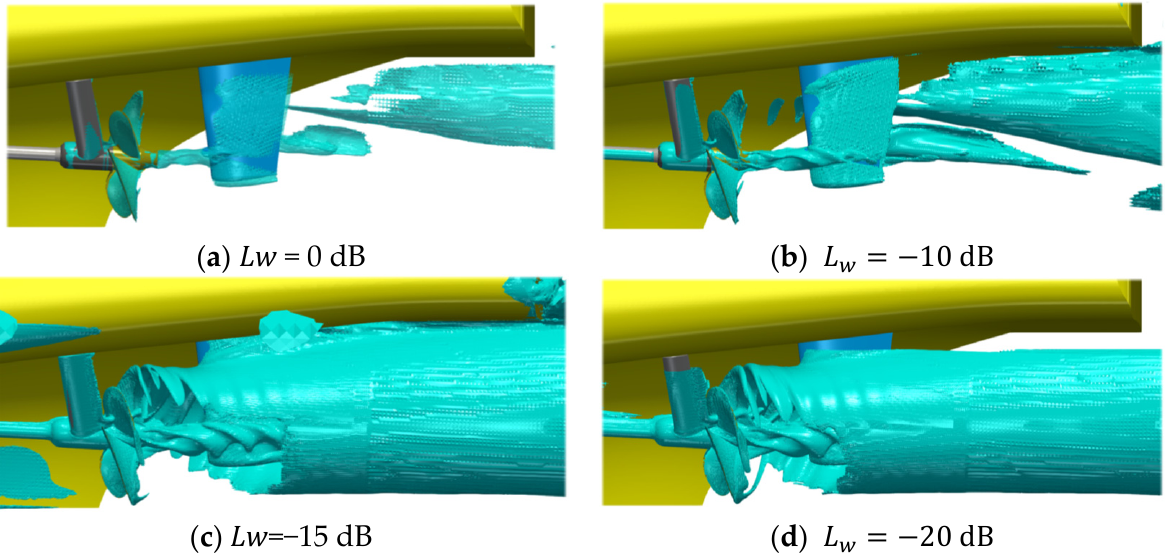
Figure 14. Comparison of Proudman acoustic power 3D isovalue around propulsor and rudder. At lower sound powers in Figure 14b, significantly more details appear as possible acoustic sources. These include a clear overlaying waveform structure on the hub vortex isosurface and a cylindrical shape of noise-generating structure between the shaft brackets and the propeller becomes visible. Also, the tip vortex immediately behind the trailing edge is highlighted, which might only be limited in visualization, by the mesh resolution of the underlying FVM fluid flow simulation. With further higher thresholds for the sound power in Figure 14c,d the tip vortex becomes dominant for all angular positions around the x -normal plane through the rudder. The noise generated by the vessel appears only in Figure 14c enclosing a part of the stern section and the transom, meaning that a constant noise level is emitted by the vessel itself, which is plausible as the flow around the hull adjacent regions is not influenced by the propulsor and should be less